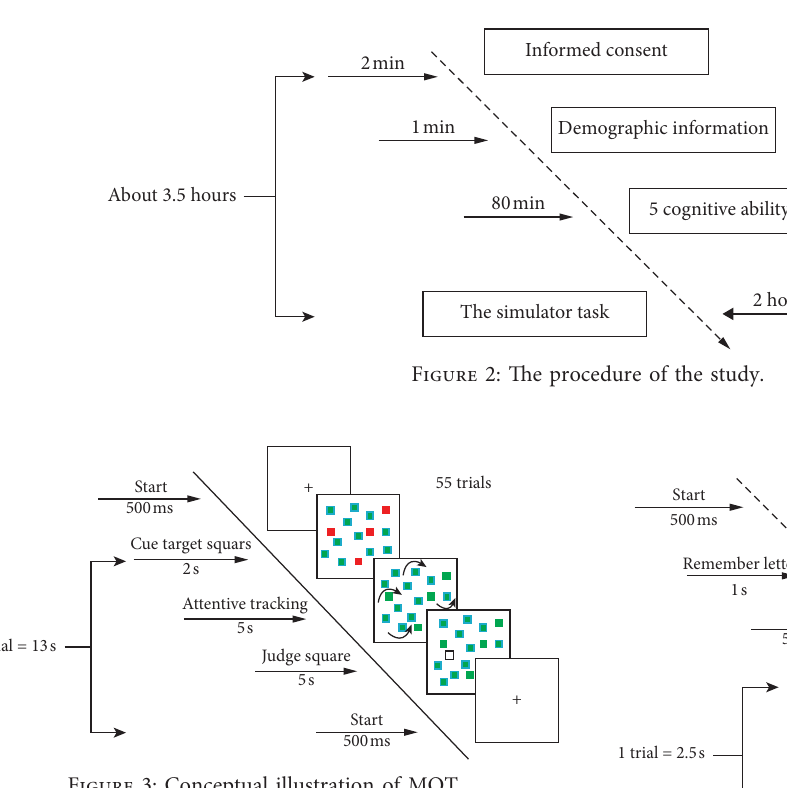
Figure 3: Conceptual illustration of MOT.